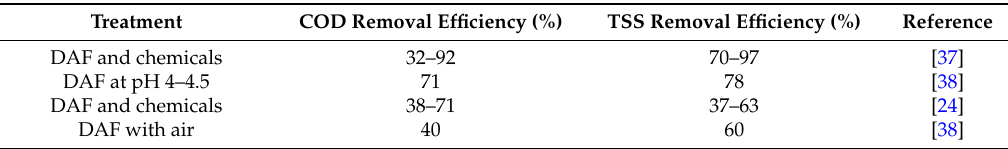
Table 10. DAF system performances for slaughterhouse wastewater